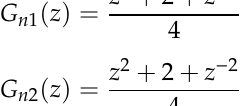
Figure 15. Setting Kp of G PI2 to move poles of T(z) into the unit circle.